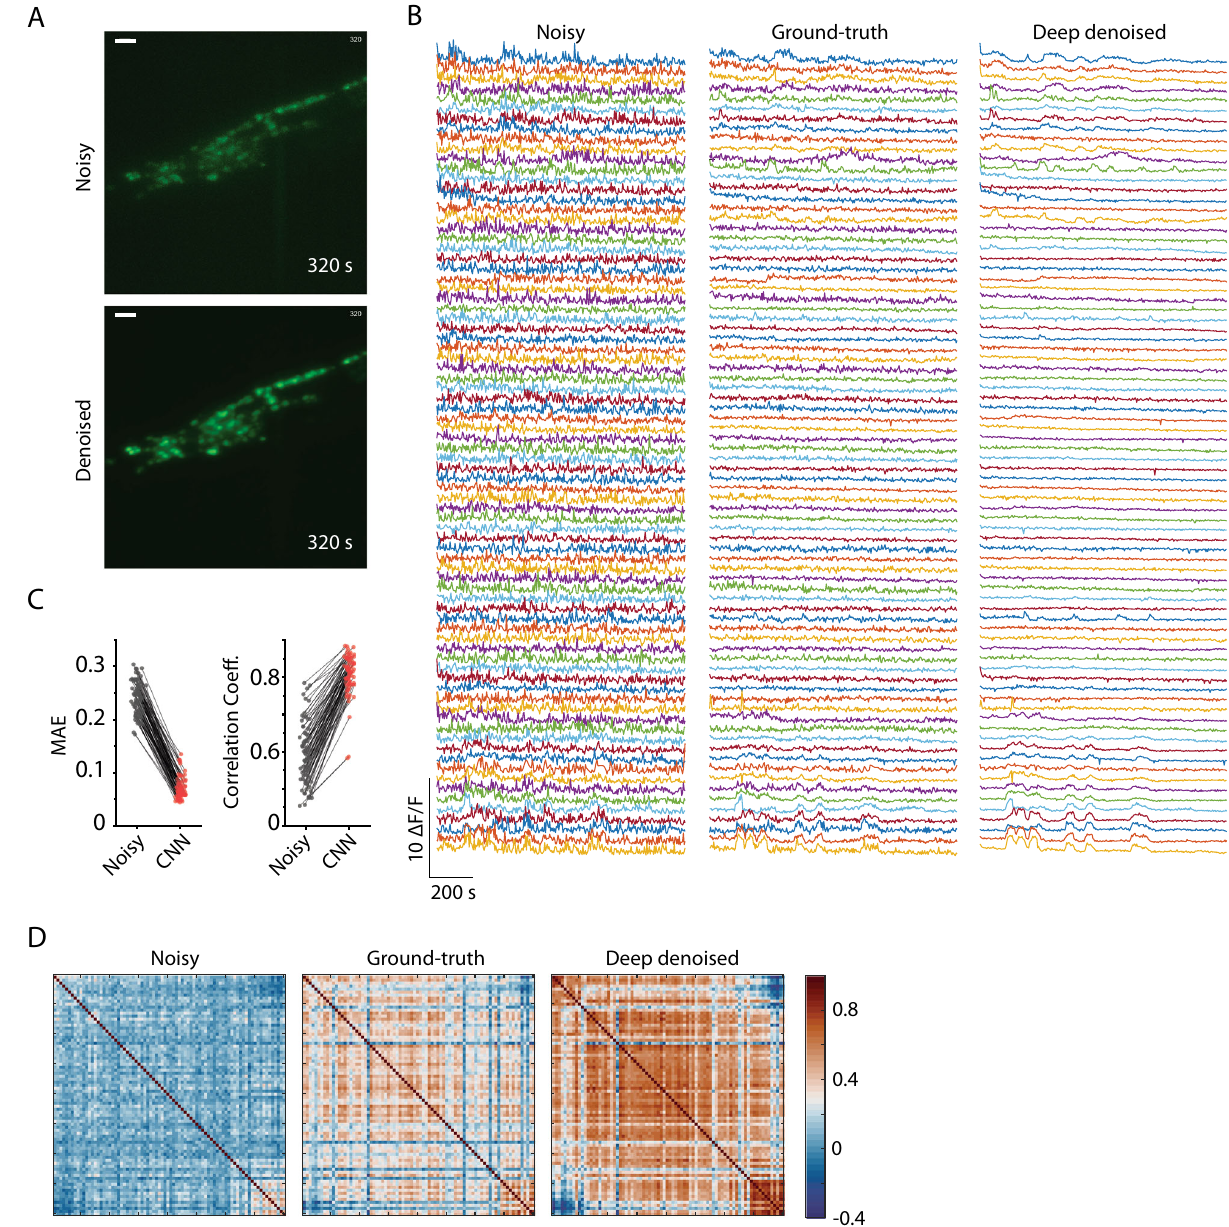
Fig. 4 | High quality whole-brain Ca trace recovery using NIDDL. A Top – max projection of an example image stack from a noisy whole-brain video recording (acquiredatlowlaserpower).Bottom – corresponding deep denoised output.Cell nucleiarelabeledwithnuclearlocalizedGCaMP5K.DatacomesfromstrainZIM504 (scalebar − 10 μ m). B Neuronactivitytracesextractedfromthenoisyvideo(shown in A ), high SNR ground-truth video for the same recording (acquired at high laser power), and deep denoised video output by network trained only on separate